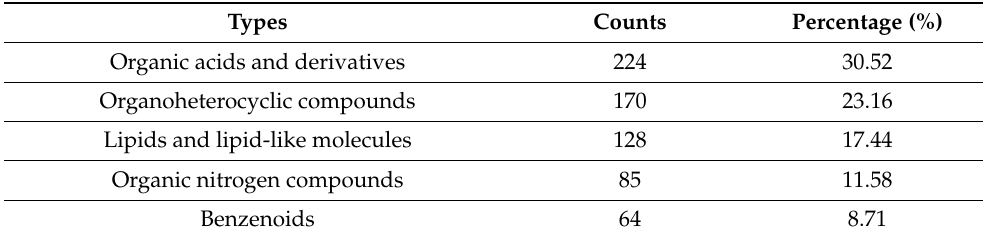
Table 1. List of various types of metabolites of Tilletia laevis